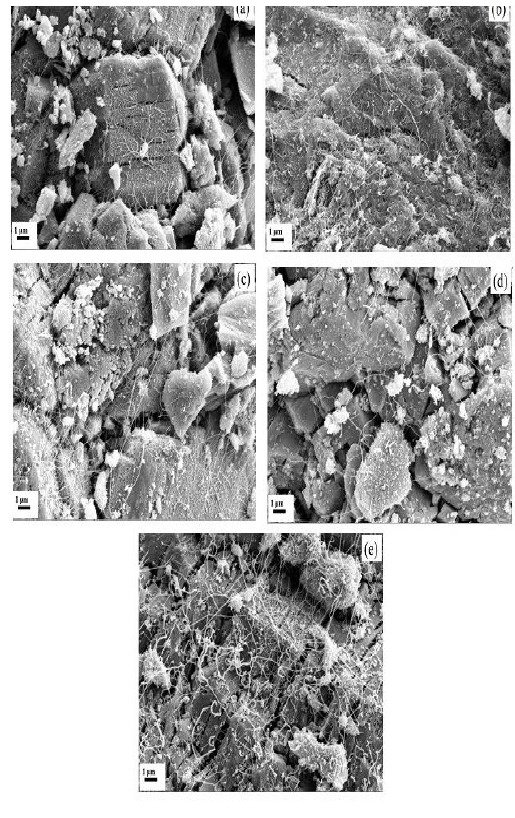
Fig. 4. SEM images of (a) Zn Figure 5 provides the measured diameter